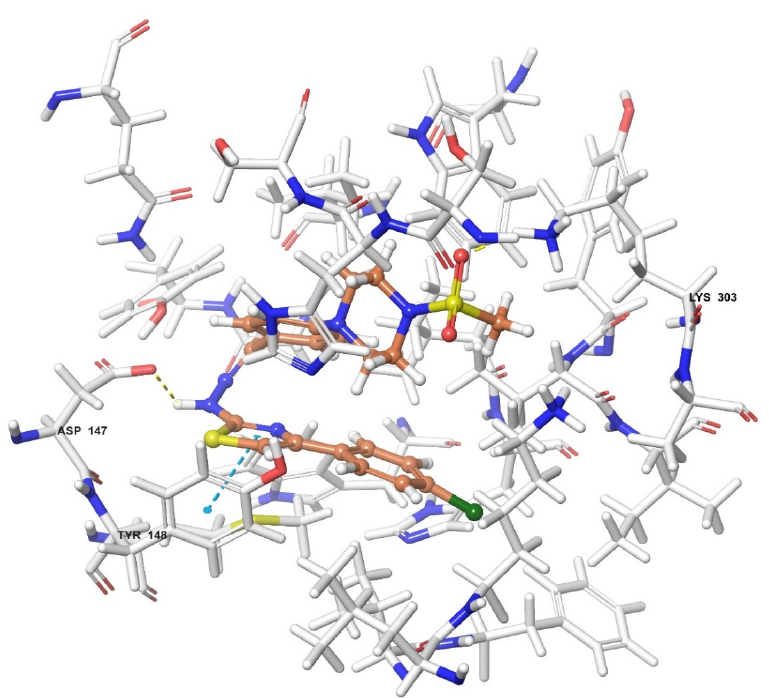
Figure 14. The three-dimensional interacting mode of compound 3g in the active region of µ -opioid receptor. The ligand and significant residues of the active site of the receptor are presented by a tube model colored with orange and white, respectively (PDB Code: 5C1M).